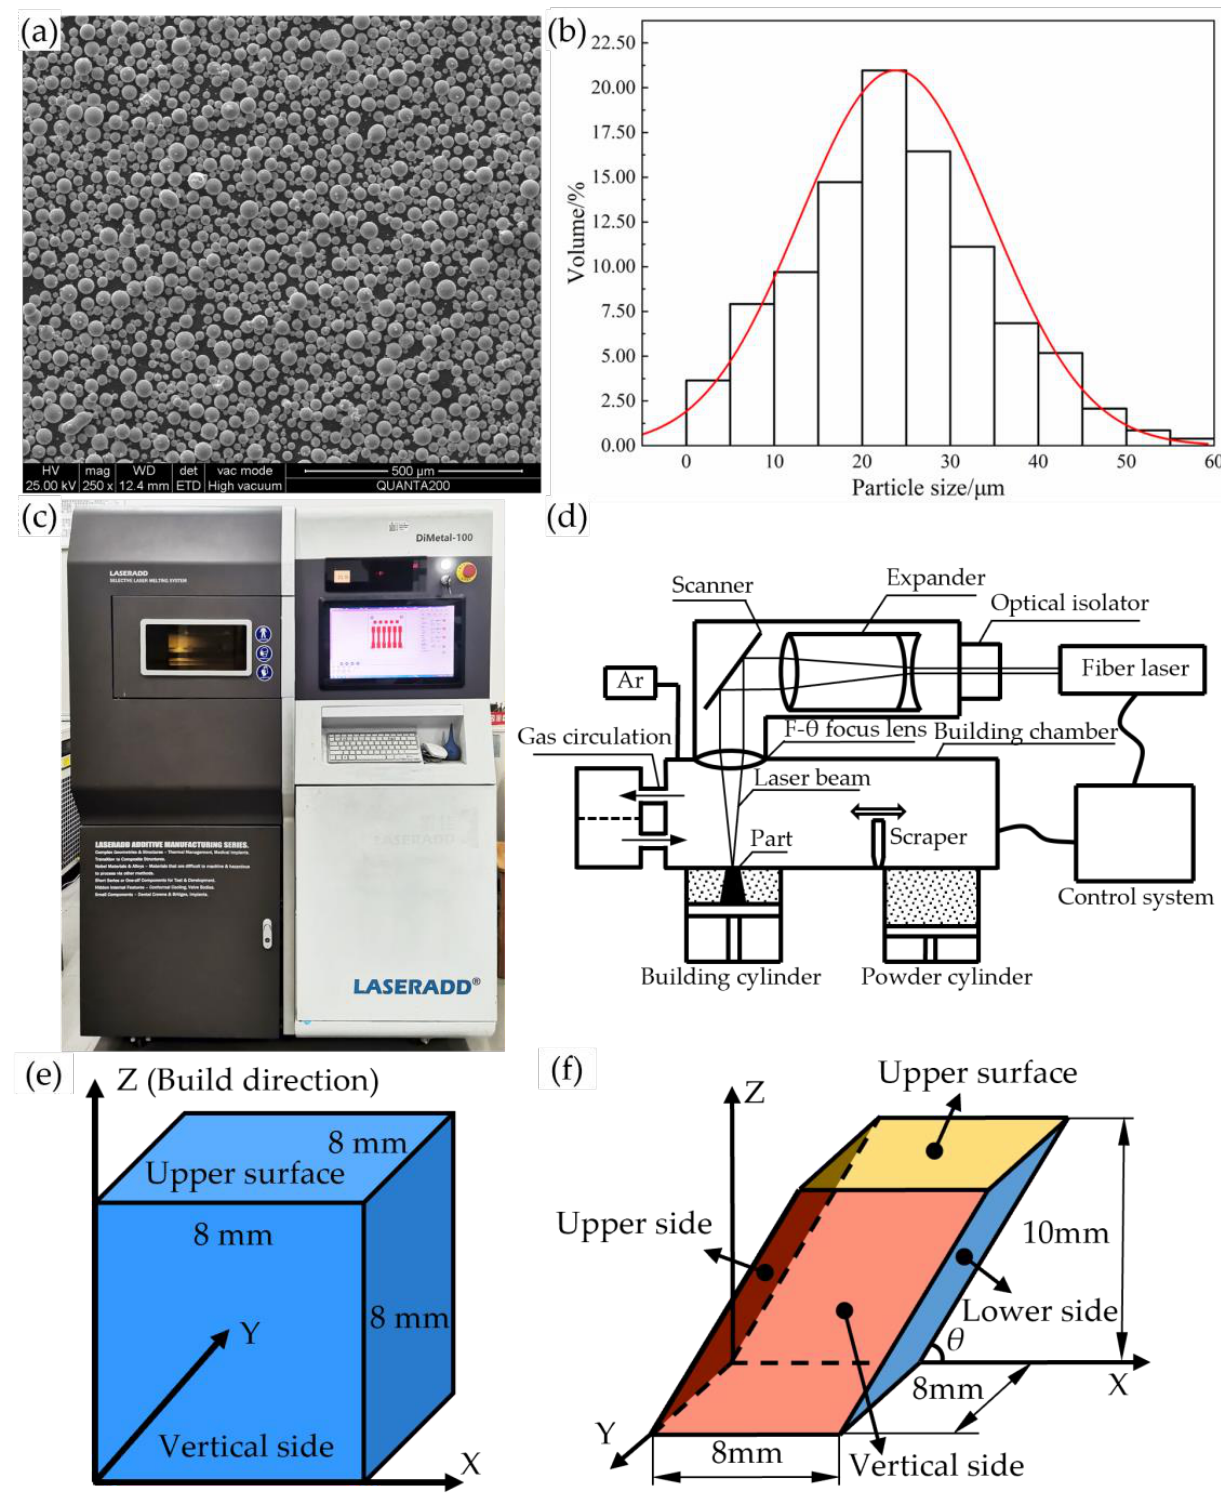
Figure 1. SLM forming model, equipment and powder: ( a ) micro morphology of Ti6Al4V powder; ( b ) particle size distribution; ( c ) the DiMetal-100 forming equipment; ( d ) the technical principles of SLM; ( e ) cube schematic; ( f ) oblique square